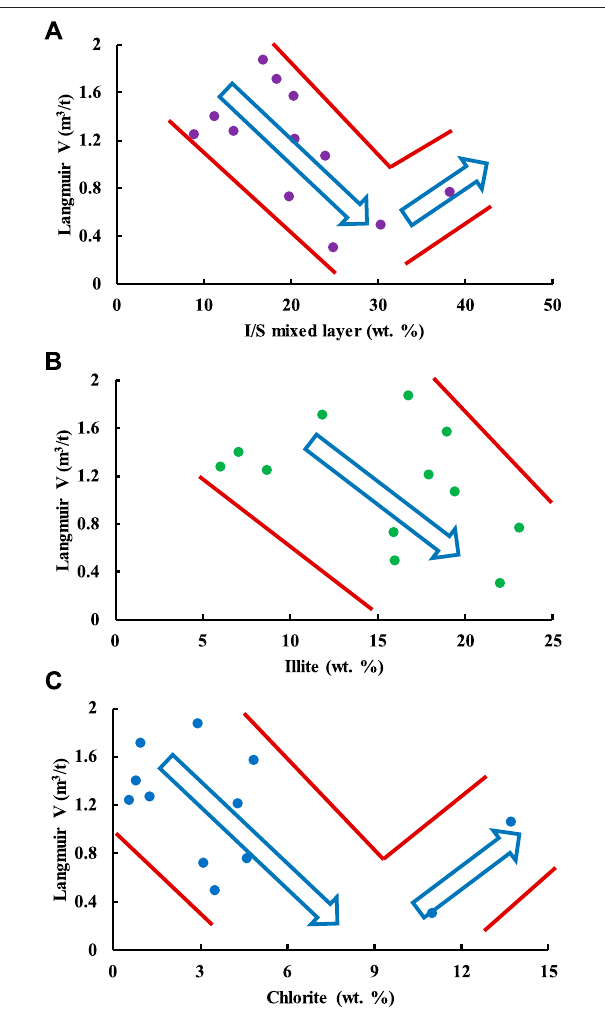
FIGURE 3 | Analysis of Langmuir Volume ’ s relation with I/S mixed layer, illite, and chlorite. It can be seen that Langmuir Volume is fi rst negatively and then positively correlated with I/S mixed layer content and with chlorite content. It is negatively correlated with illite content.